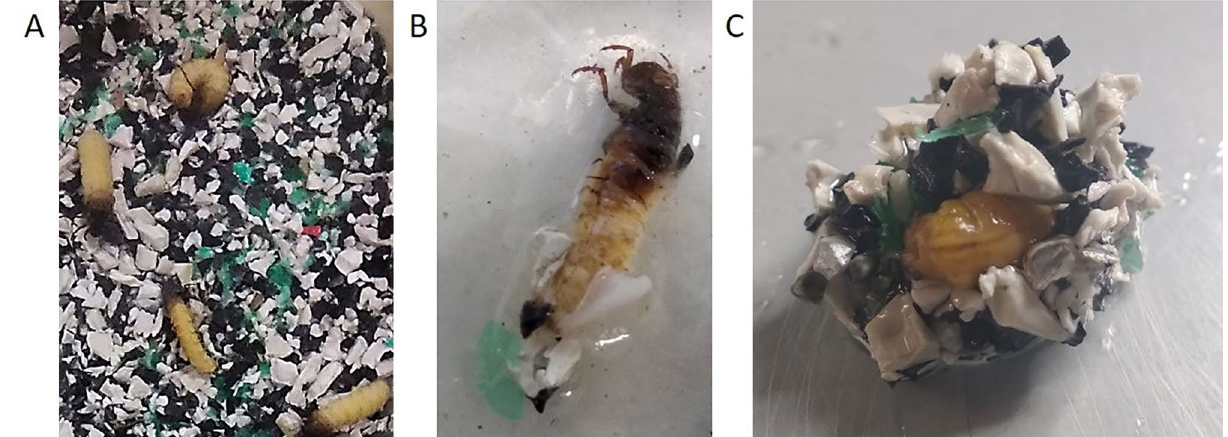
Figure 5. The case rebuilding during the experiment 1 (EXP1). ( A ) Caddisflies exposed to substrate with a mixture of lMP (PS, PET, PP in equal proportions); ( B ) initial phase of case rebuilding with lMP; ( C ) case rebuilt observed from dorsal vision. The images ( A ), ( B ) and ( C ) are obtained by the software PowerPoint (ver. 2002, https ://www.micro soft.com/it-it/micro soft-365/power point